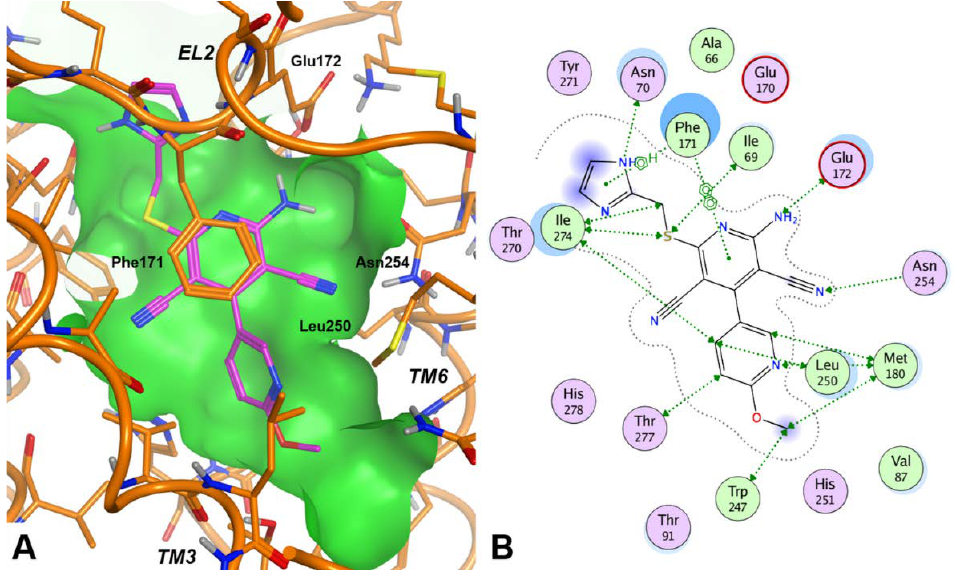
Figure 3. ( A ) Binding mode of the synthesized compounds at the hA 1 AR cavity; 9 -receptor interaction is shown, with indication of key receptor residues. ( B ) Schematic view of the ligand–target interaction (developed with the Ligand Interaction tool within MOE).